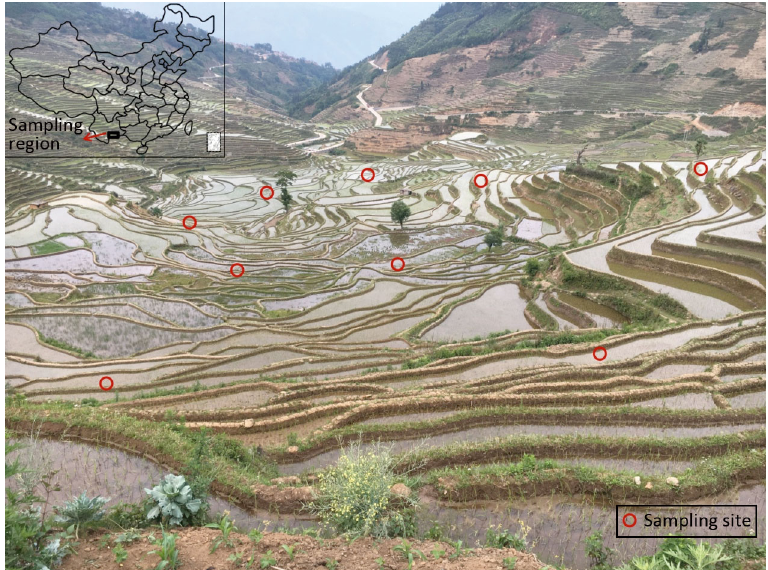
Fig. 1. Sampling sites uniformly placed in the village of Nimei, located in Honghe County in the core area of the Honghe Hani Rice